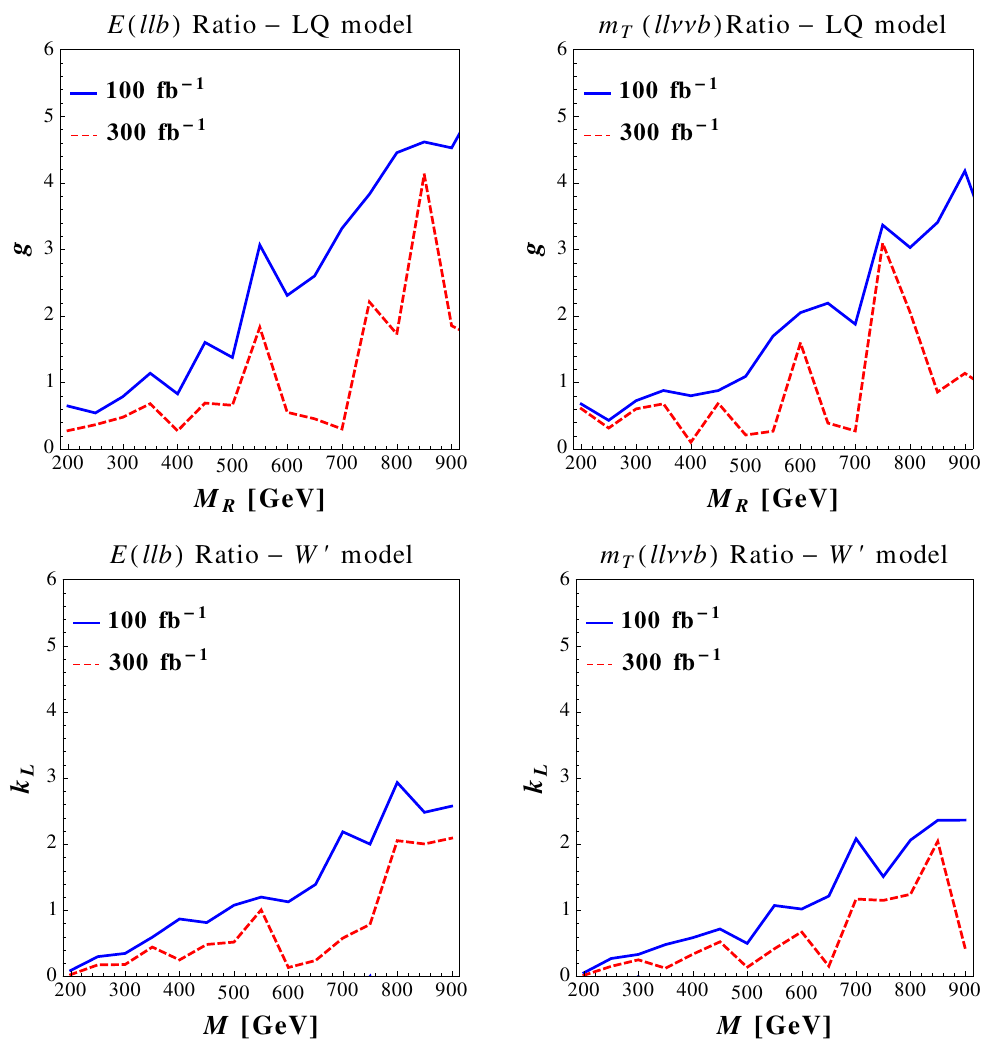
Figure 11 . Projected 95% exclusion limits using the ratio R x given in eq. (6.1) assuming errors are purely statistical. The left (right) plot is for x = E ( ‘‘b ) ( m T ), and the blue solid lines (red dashed) are for 100 (300) fb (cid:0) 1 . The top (bottom) row is for the leptoquark ( W 0 )